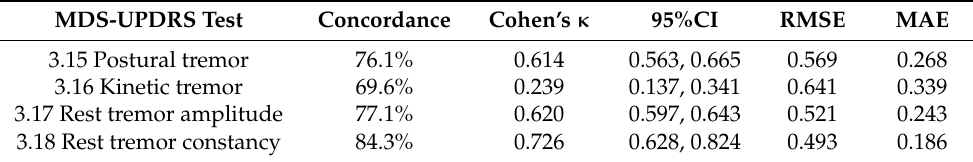
Table 3. Agreement results.